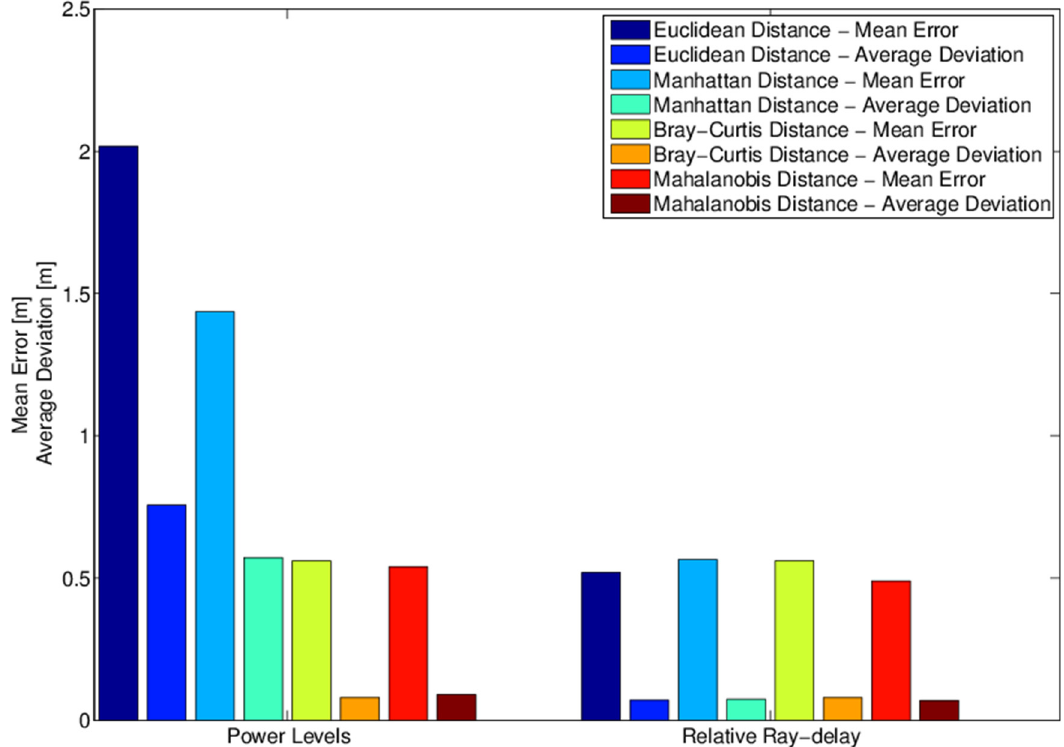
Figure 18. Case 3 results: Localization error when comparing power vs. delay detection methods with four distance metrics in a section of 200 × 120 m. Table 3. Outdoor simulations results: Localization error when comparing power vs delay detection methods and distance metrics in each scenario.